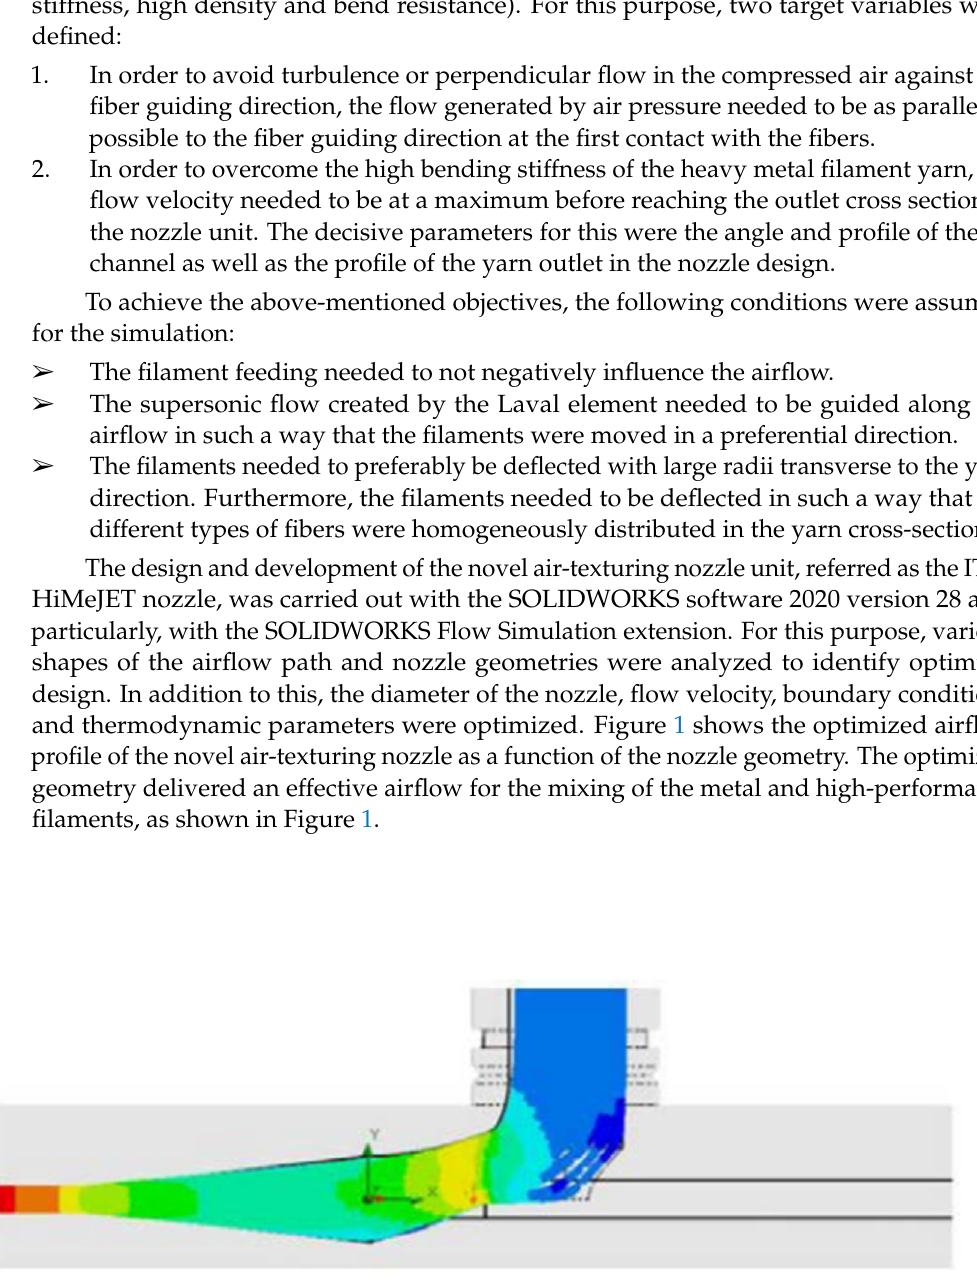
( c ) Figure 2. Novel air-texturing nozzle produced with additive manufacturing technique: ( a ) feed sec- tion, ( b ) main module and ( c ) delivery section. 2.2. Development of Innovative Hybrid Yarns In this phase, the new air-jet nozzle was installed on an air-jet texturing machine (Stahle-Eltex GmbH, Weil am Rhein, Germany) to study the influence of the nozzle design on the commingling behavior. For this purpose, the air pressure, feeding speed, take-off speed and overfeeding percentage were adjusted for the development of the innovative commingled yarn. The investigation revealed that an air pressure of 3 bar and an overfeed of 5% were the optimum parameters for producing the innovative hybrid yarn based on metal, high-performance and thermoplastic filaments. It was also observed during the ex- perimentation that slippage of the metal filaments occurred on the feed godet, especially when a high overfeed was used. To reduce the slippage, a polyolefin shrink sleeve was used on the godet. The results showed that hybrid yarn based on the novel air-texturing nozzle had a very high degree of opening and mixing as well as low fiber damage, as shown in Figure 3.